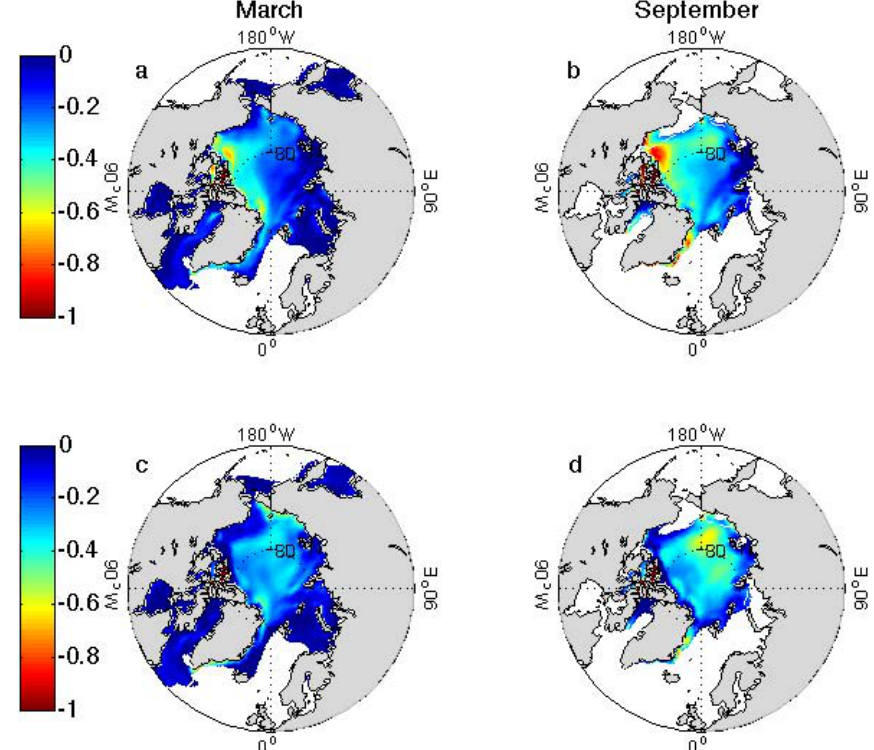
Fig. 14. March and September sea ice thickness change (in meters) due to light-absorbing particles in snow and sea ice, for BC only (a, b) and for dust only (c, d) .